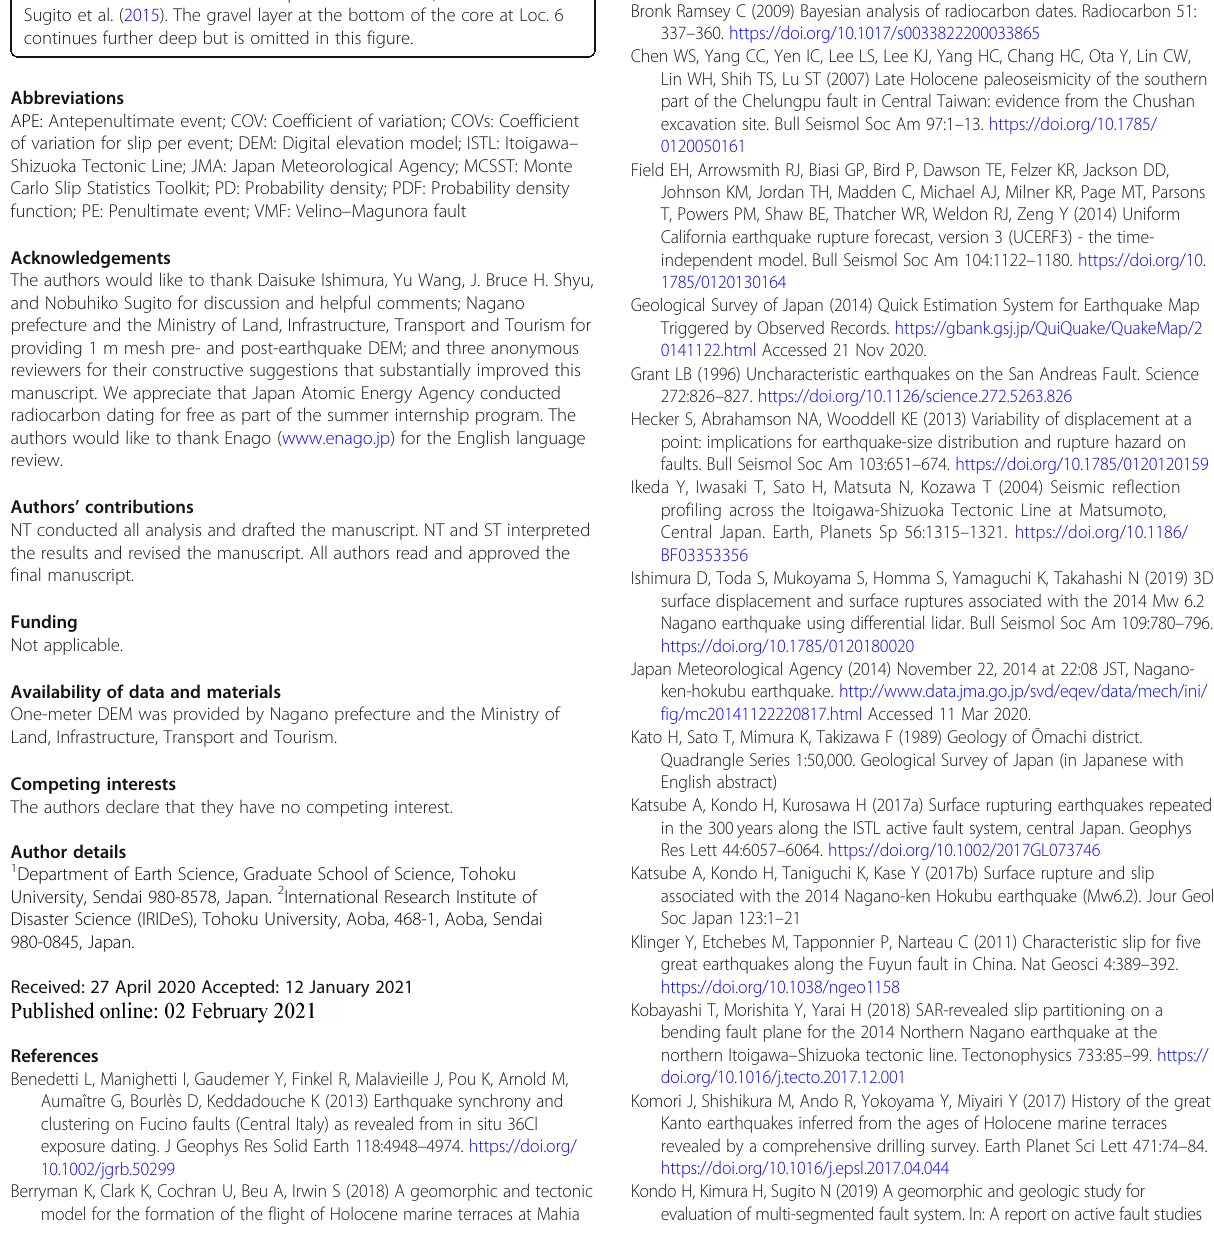
Additional file 4: Figure S4 . Geologic columnar sections of drilled cores from which radiocarbon samples were obtained, modified from Sugito et al. (2015). The gravel layer at the bottom of the core at Loc. 6 continues further deep but is omitted in this